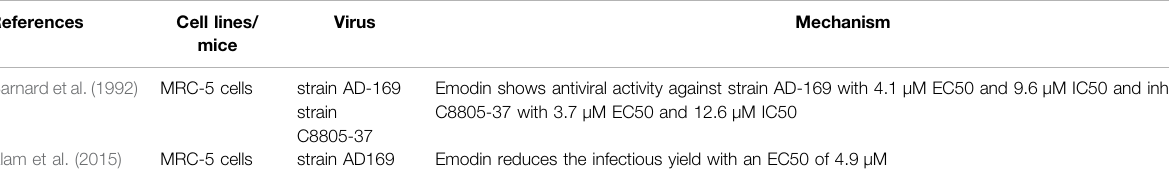
TABLE 2 | Anti-HCMV activities of